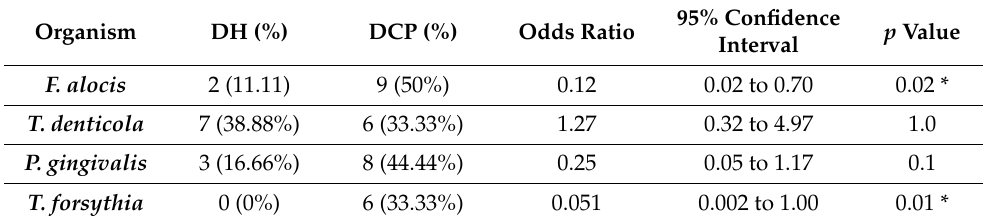
Table 3. Occurrence of red complex bacteria in the presence or absence of F. alocis .